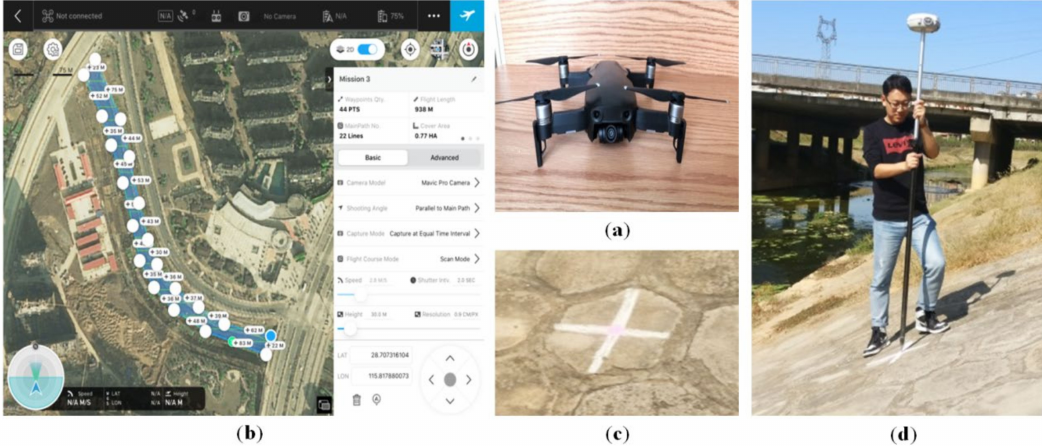
Figure 2. Unmanned aerial vehicle (UAV) data acquisition and ground control point measurement. ( a ) DJI Mavic Air, ( b ) DJI graphical user interface for mission planning, ( c ) ground control point (GCP) marked by a white cross with a pink center, and ( d ) field measurement of